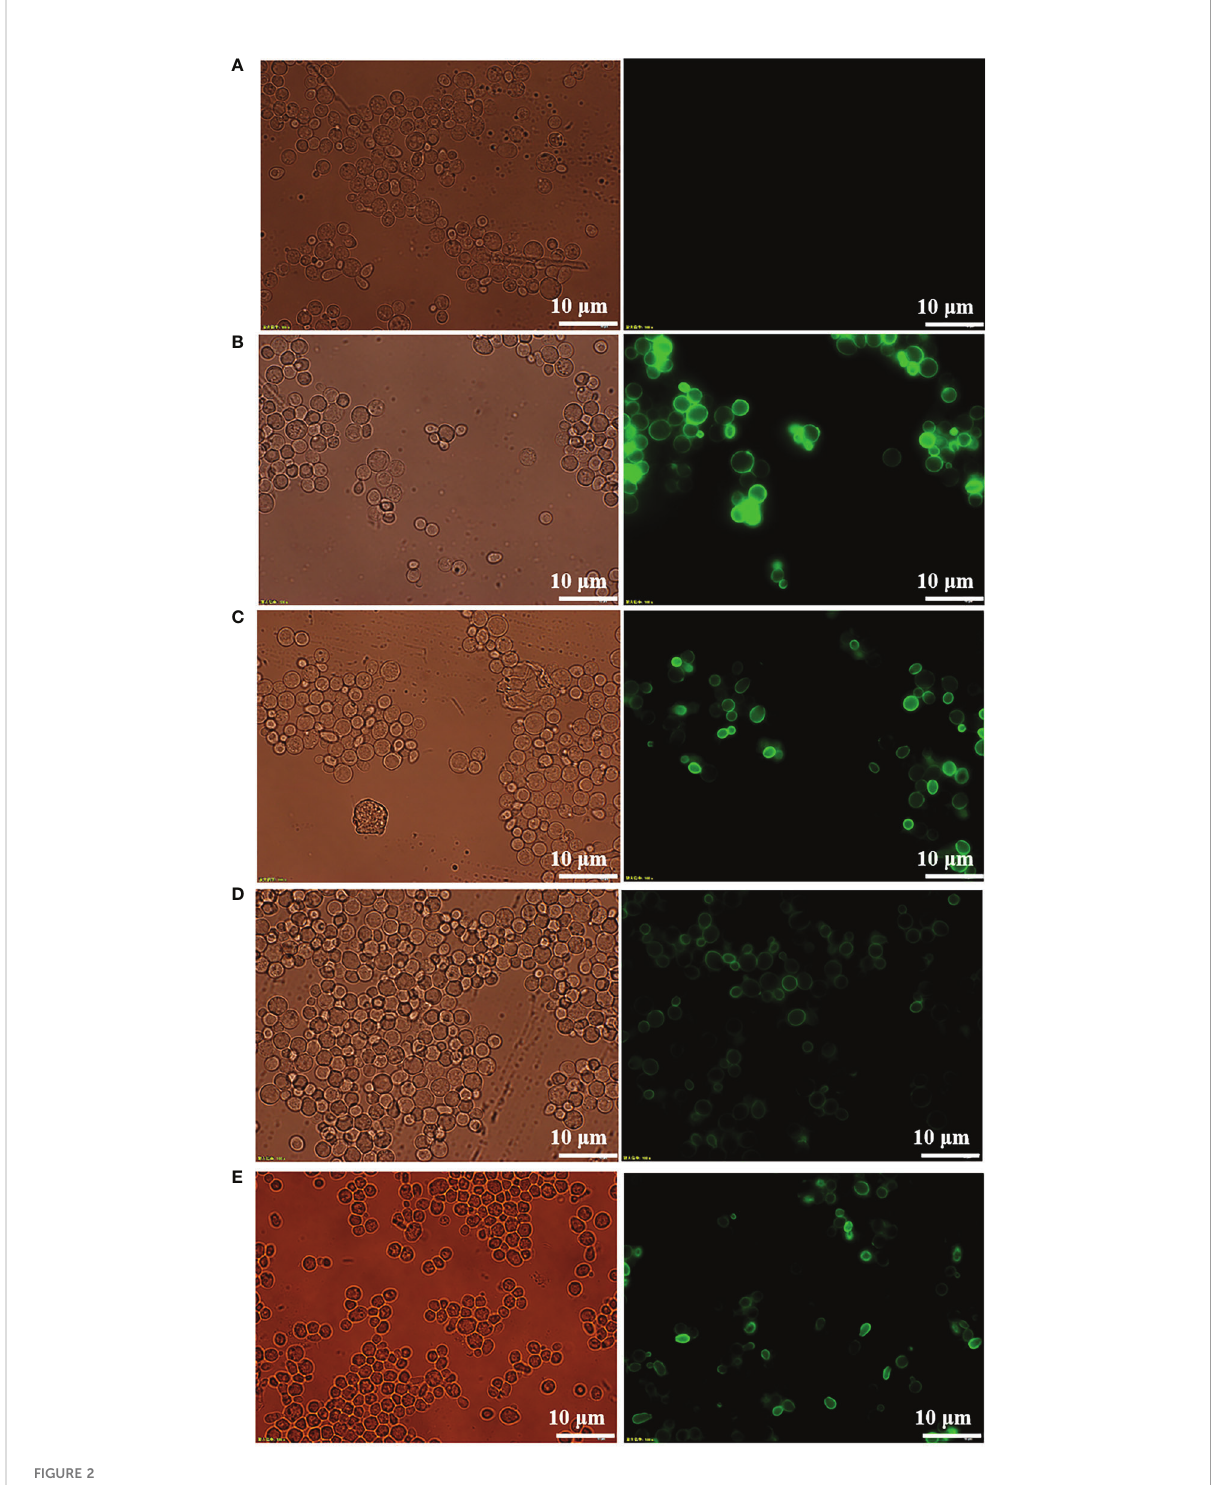
FIGURE 2 Immuno fl uorescence microscopy of recombinant yeast cells. (A) pYD1/EBY200. (B) pYD1-RBD (WT)/EBY200. (C) pYD1-mRBD (B.1.17)/EBY200. (D) pYD1-mRBD (B.1.617.1)/EBY200. (E) pYD1-mRBD (B.1.351)/EBY200 (left: light; right: matching fl uorescence, Scale bar: 10